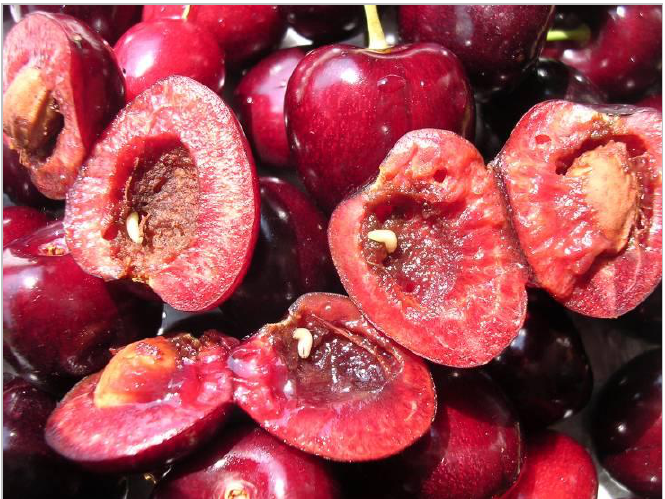
Figure 3. Infested